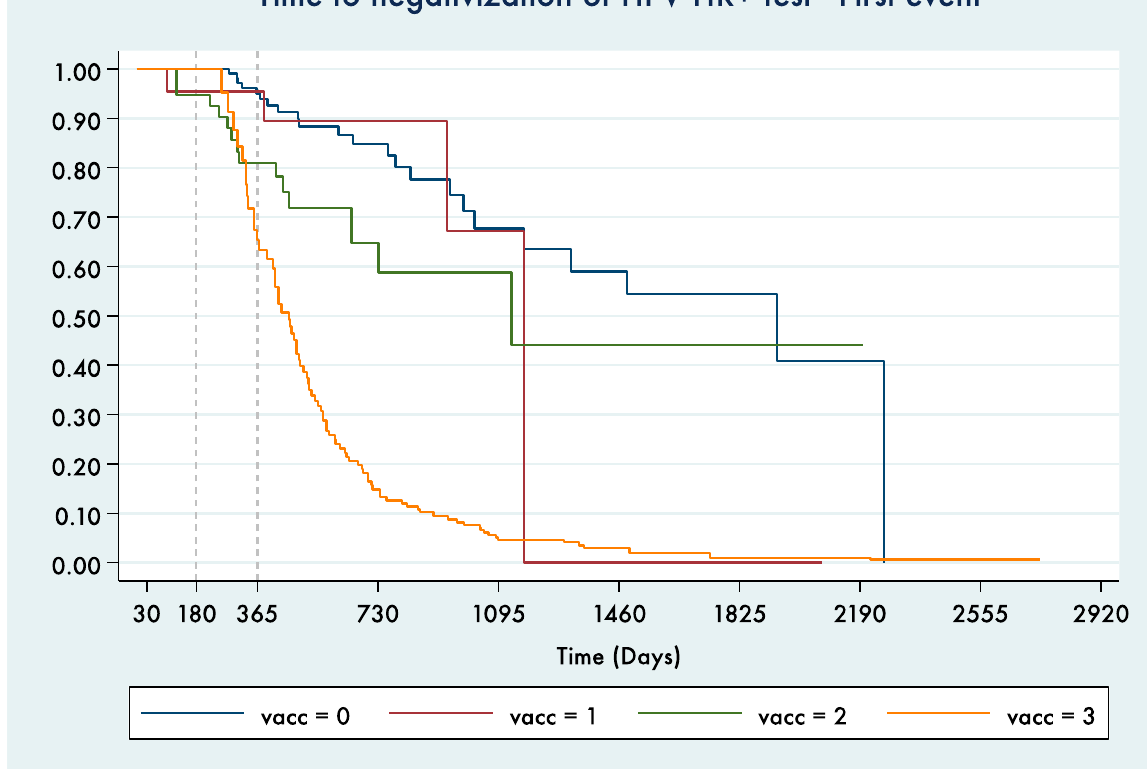
Figure 4. Kaplan–Meier curve for time to negativization of an HPV HR+ test. Only the time to the 1st HPV LR+ or HPV negative test after a positive HPV HR+ test was considered (0—before vaccination, 1—exposed to 1st dose, 2—exposed to 1st and 2nd dose, 3—exposed to all 3 doses).